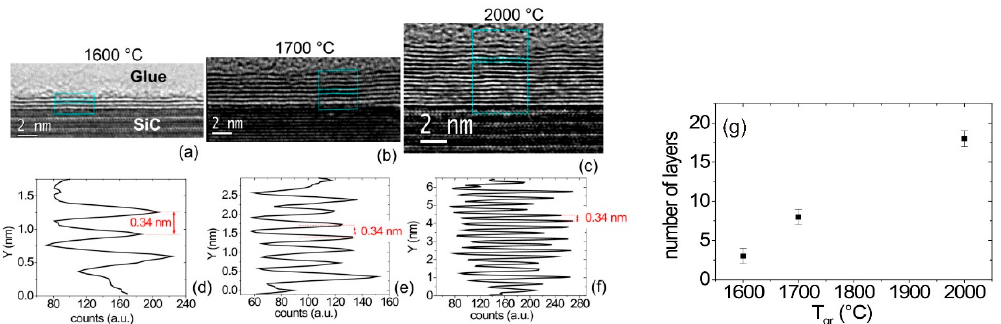
Figure 24. HRXTEM analyses on the samples annealed at different temperatures. Images on the samples annealed at 1600 ( a ), 1700 ( b ) and 2000 °C ( c ), and corresponding line scans (( d ), ( e ) and ( f )), showing three, eight and 18 layers grown on the surface of 4H-SiC, respectively; ( g ) number of graphene layers vs. growth temperature [126].